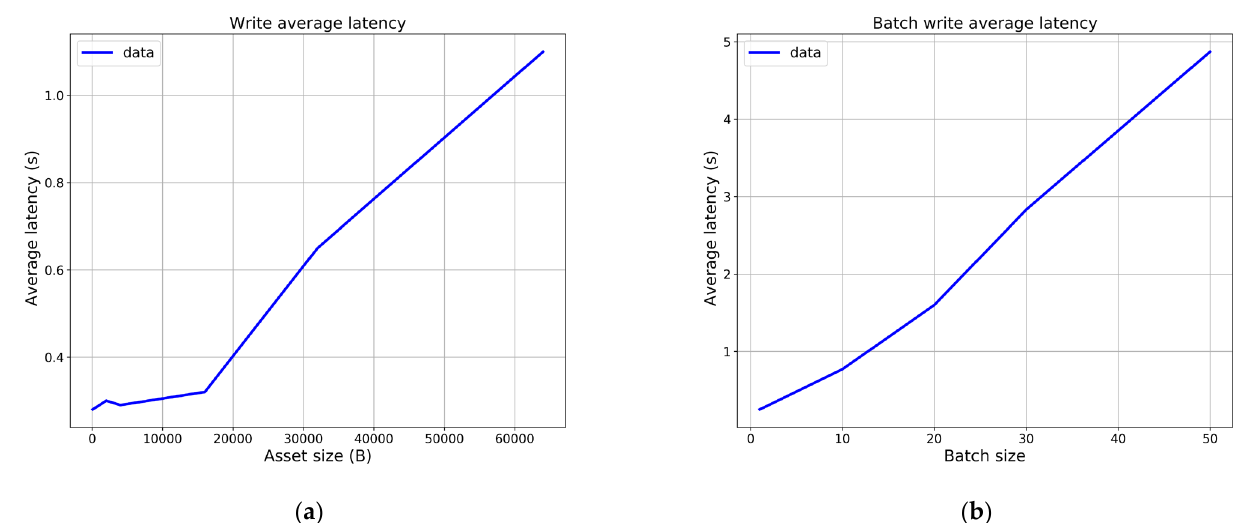
Figure 16. Write average latency ( a ) single write; ( b ) batch write.